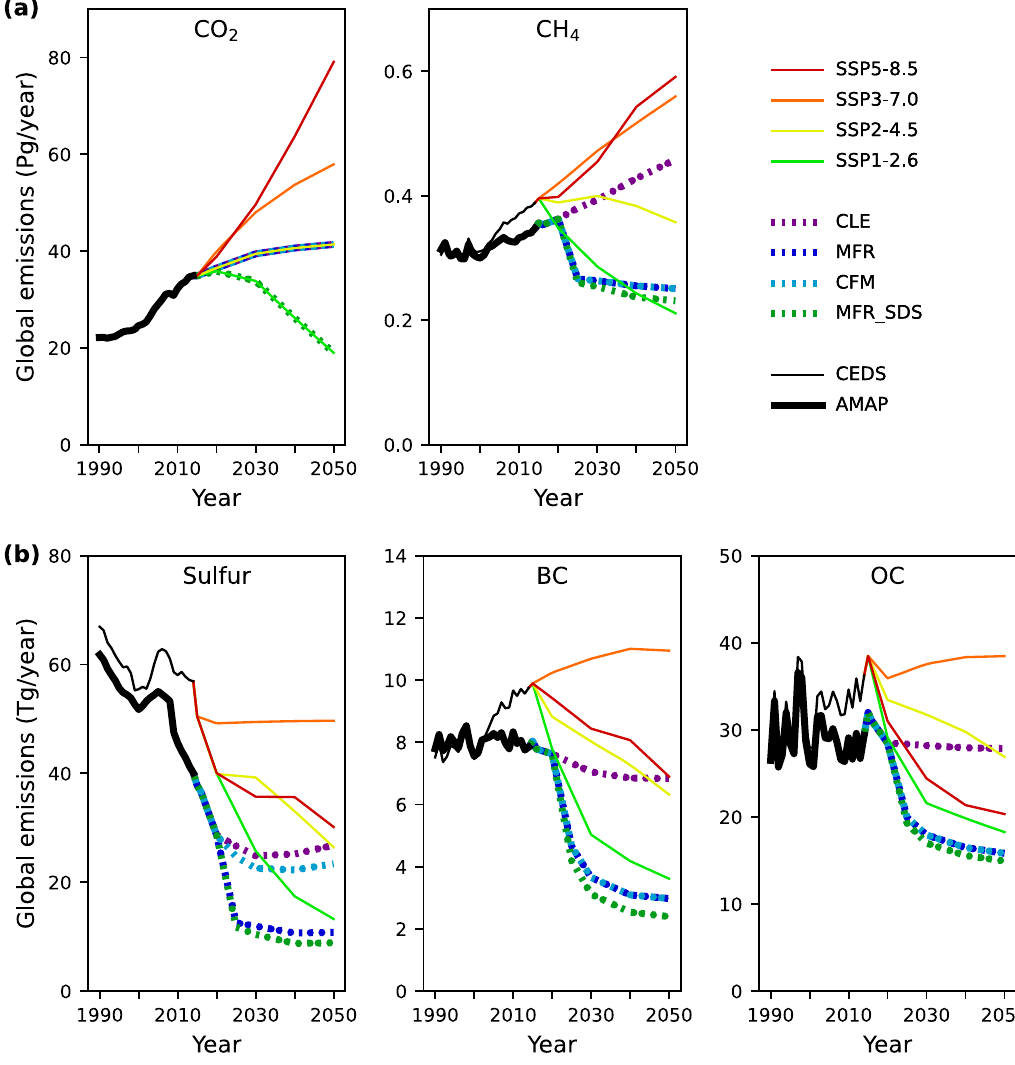
Fig. 1 Global and annual mean greenhouse gas and particulate matter component emissions for the recent historical time period and in future scenarios. a Historical carbon dioxide (CO 2 ) and methane (CH4) emissions in two inventories (as indicated in the legend; thin black line: Community Emission Data System, CEDS 56 , thick black line: Arctic Monitoring and Assessment Programme, AMAP 27 ) and 8 future scenarios 26,27 for 2015 to 2050 (colored lines and acronyms in legend); also see the section describing the future scenarios. b Corresponding emissions of sulfur, black carbon (BC), and organic carbon (OC). Note that some of the scenarios are overlapping for some emitted species. The inter-annual variability in the historical methane, BC, and OC emissions is largely due to wild fi res. See Supplementary Figs. 1, 2 for regional contributions to global